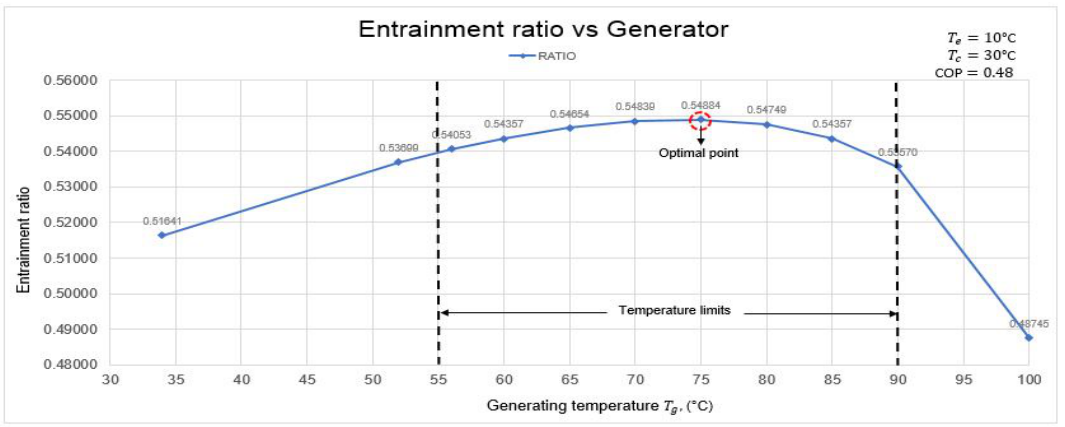
Figure 6. Entrainment ratio with respect to the generator